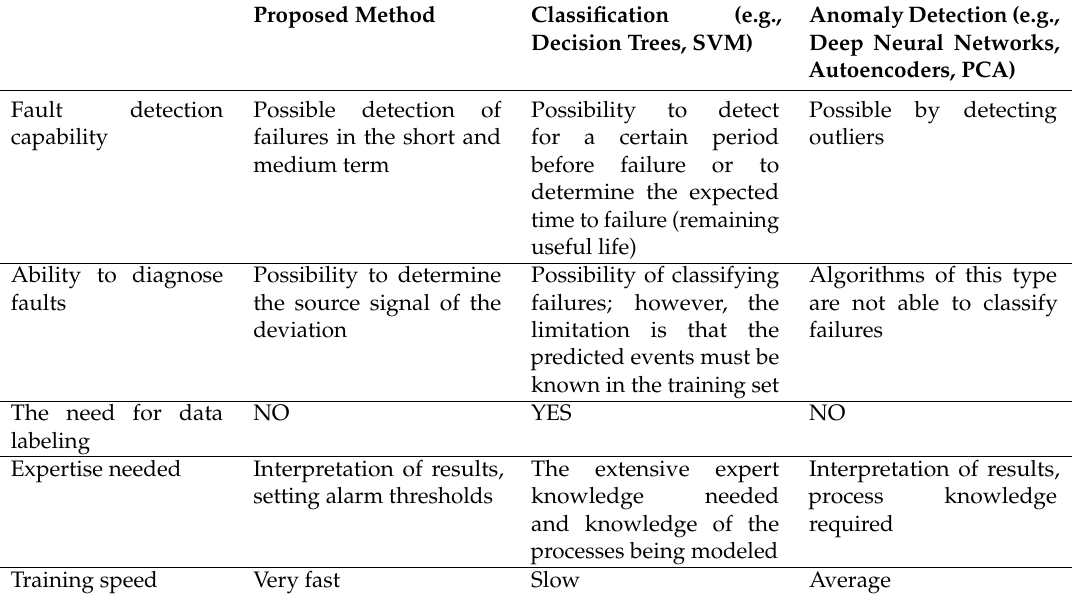
Table 6. Benefits and limitations of different approaches for the considered